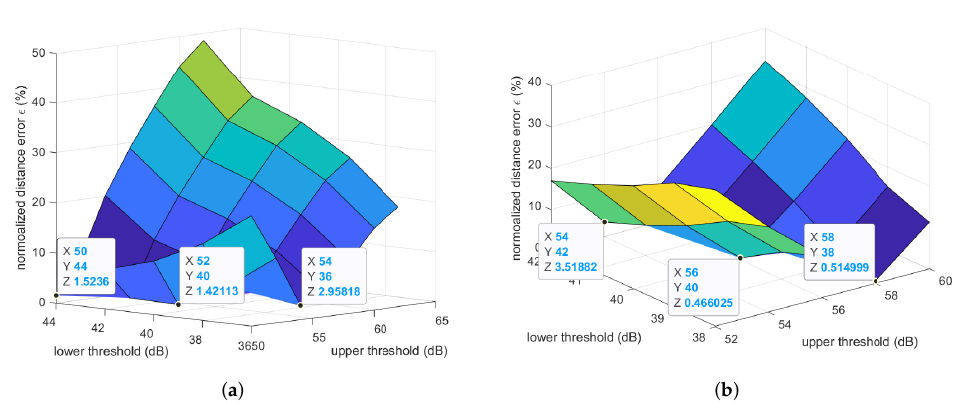
Figure 7. Normalized step length estimation errors of the indoor experiments. ( a ) Indoor walking; ( b ) indoor